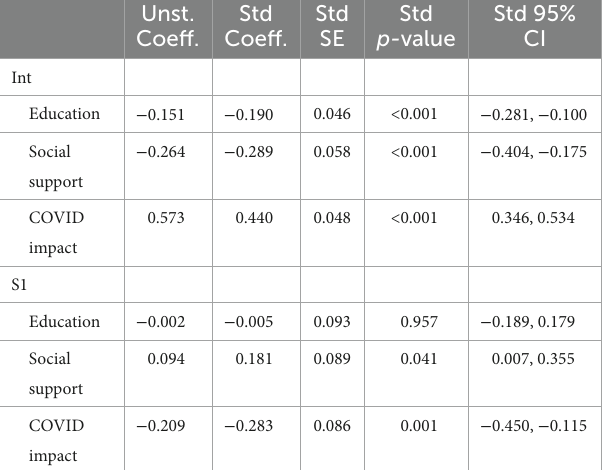
TABLE 5 Regression estimates from final piecewise growth model. Unst.